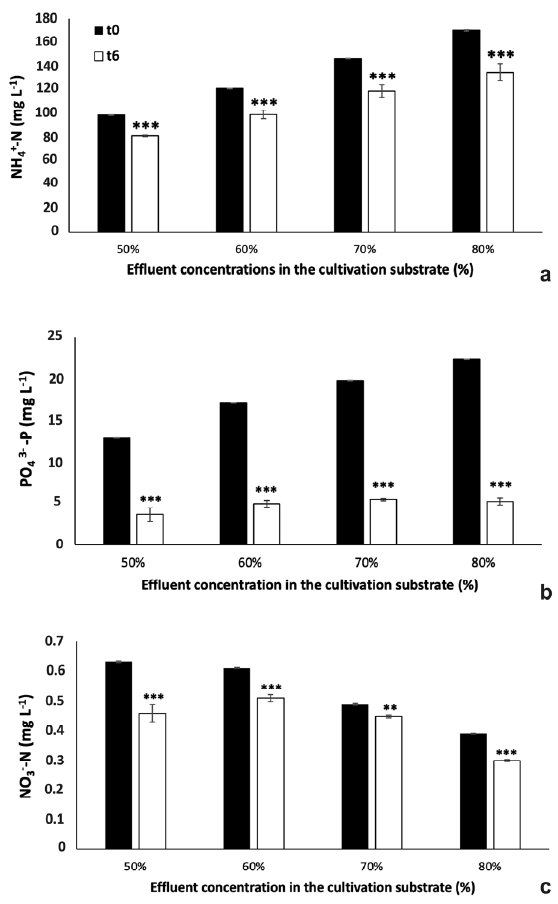
Figure 8. Nutrients concentrations (( a ) NH 4+ -N, ( b ) PO 43 − -P, ( c ) NO 3 − -N; mg L − 1 ) in winter-season filtered centrate stream, diluted at different concentrations (50%, 60%, 70%, and 80% of effluent in freshwater), at the inoculation time and after 6 days of cultivation of Chlorella sp. algae. Black histograms, before inoculation (t = 0); white histograms, 6 days of cultivation (t = 6 days). For each sample, values refer to means ± s.d. ( n = 3). In all cases, for each sample, two-tails Student’s t test was performed comparing concentrations data recorded at time 0 with those at time 6 days. ** p < 0.01; *** p < 0.001.